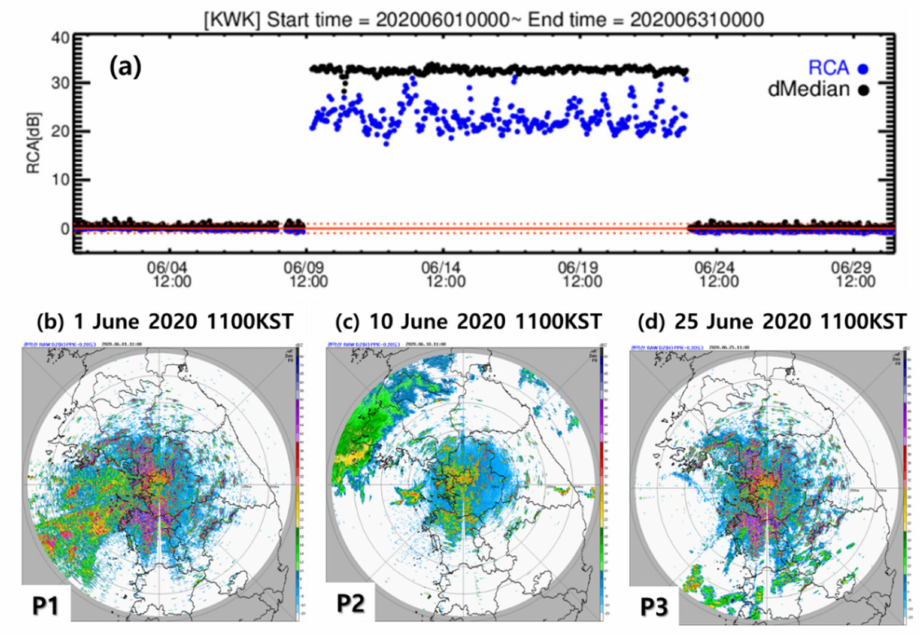
Figure 8. Example of elevation angle slip issue. ( a ) Time series of RCA (blue) and dMedian (black) for MYN radar from 0000 KST 1 June 2020 to 0000 KST 31 June 2020. The black and blue dots represent the RCA and dMedian. PPIs of ZH at the elevation angle of − 0.2 ◦ of KWK radar at ( b ) 1 June 2020 1100 KST (P1), ( c ) 1 June 2020 1100 KST (P2), and ( d ) 25 June 2020 1100 KST